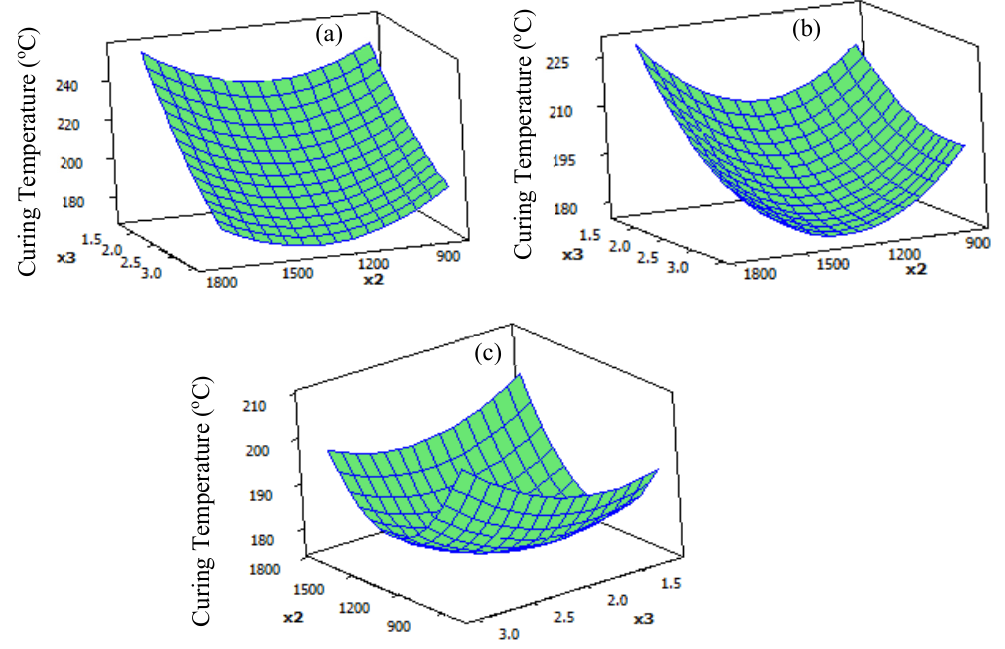
Figure 10. Surface plots for effects of lignin M w and F/P on curing temperature of BPF resoles at substitution of phenol with lignin at ( a ) 0.25; ( b ) 0.50; ( c ) 0.75.